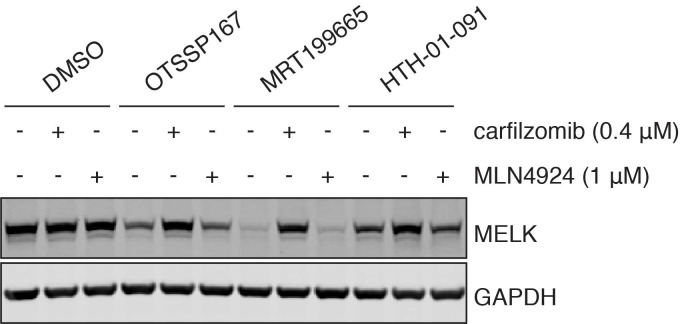
MELK inhibitor-induced MELK degradation is dependent on the proteosome, but not the cullin-RING ubiquitin ligase family.Immunoblots for MELK and GAPDH after pretreatment of MDA-MB-468 cells with carfilzomib (400 nM) or MLN4924 (1 μM) for 4 hours, followed by treatment of 1 μM of OTSSP167, MRT199665 or 10 μM of HTH-01-091 for 4 hours.